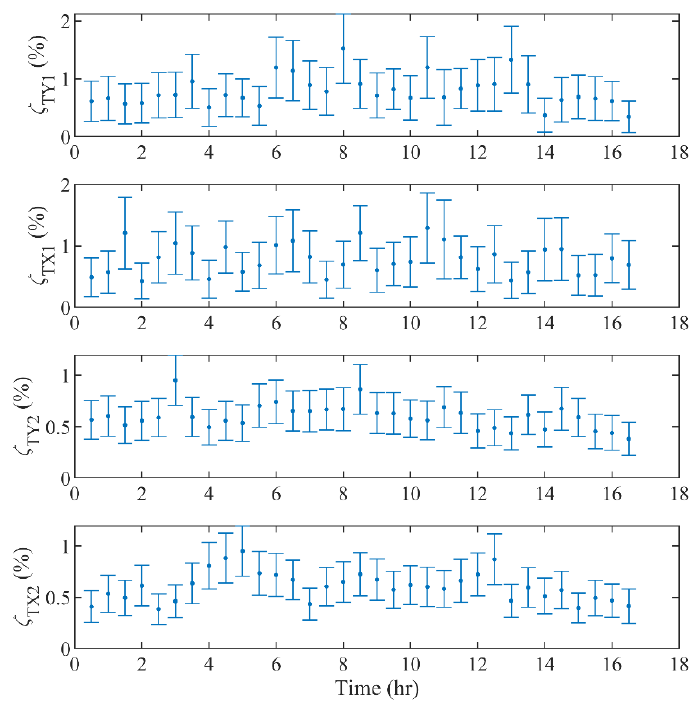
Figure 12. Time history of the identified damping ratio.